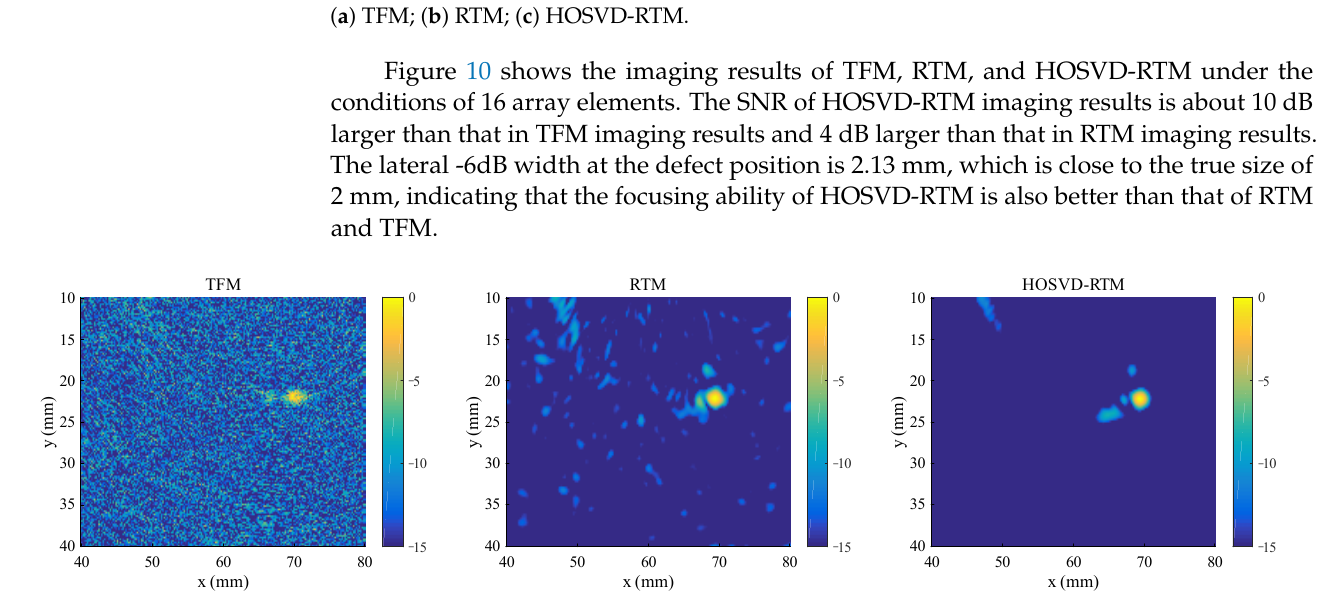
Figure 9. Imaging results obtained with the array composed of 8 elements and different algorithms. ( a ) TFM; ( b ) RTM; ( c ) HOSVD-RTM.